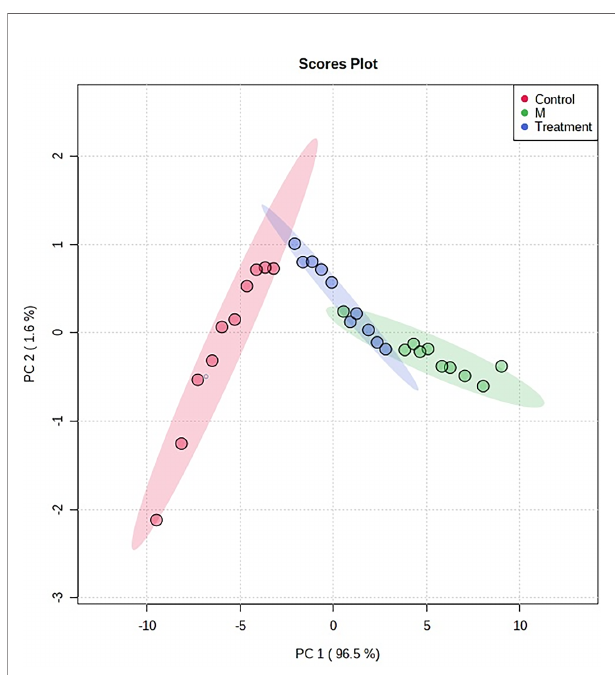
FIGURE 7 | The PCA score plot of control, model group and HNK-treated groups in urine metabolism pro fi le. M, model group. The red dot indicates the control group, the green dot indicates the model group, and the blue dot indicates the treatment group.